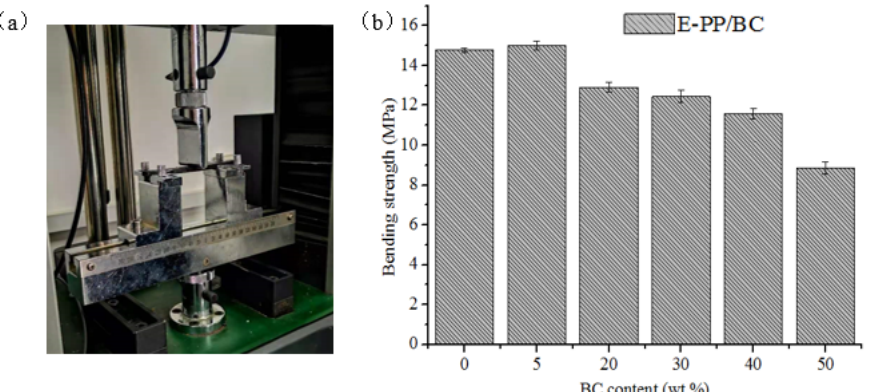
Figure 8. Mechanical testing and results: ( a ) picture of static mechanical performance testing and ( b ) bending strength of foamed E-PP/BC composites with different BC content.